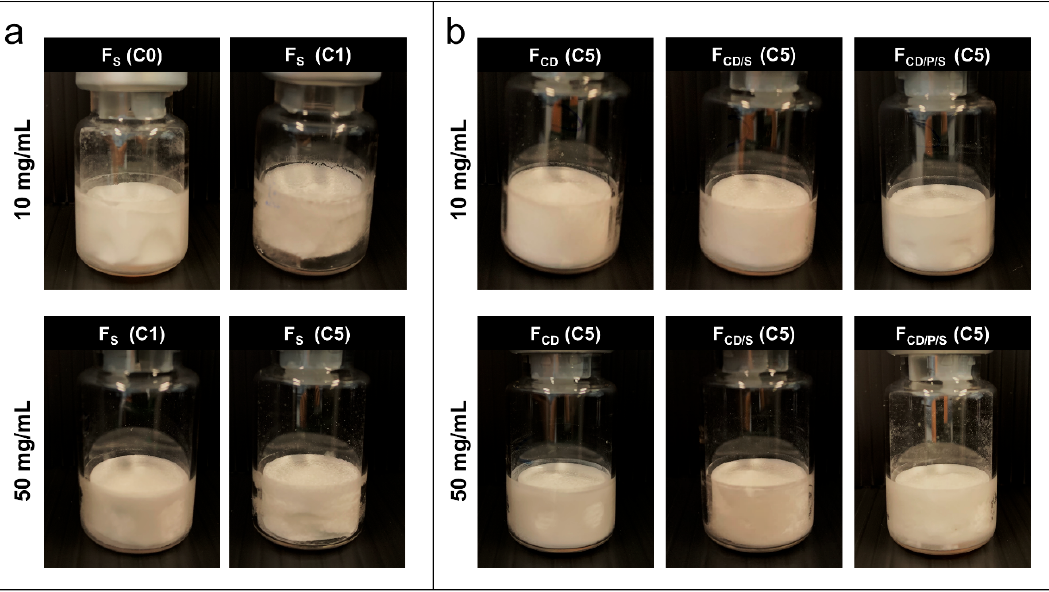
Figure 2. Cake appearance. Representative lyophilisates for 10 mg/mL formulations (upper row) and 50 mg/mL formulations (lower row). ( a ) Different cake appearances for reference formulation (F S ) depending on freeze-drying cycle and ( b ) cake appearance obtained for F CD , F CD/S , and F CD/P/S exemplarily shown for C5.